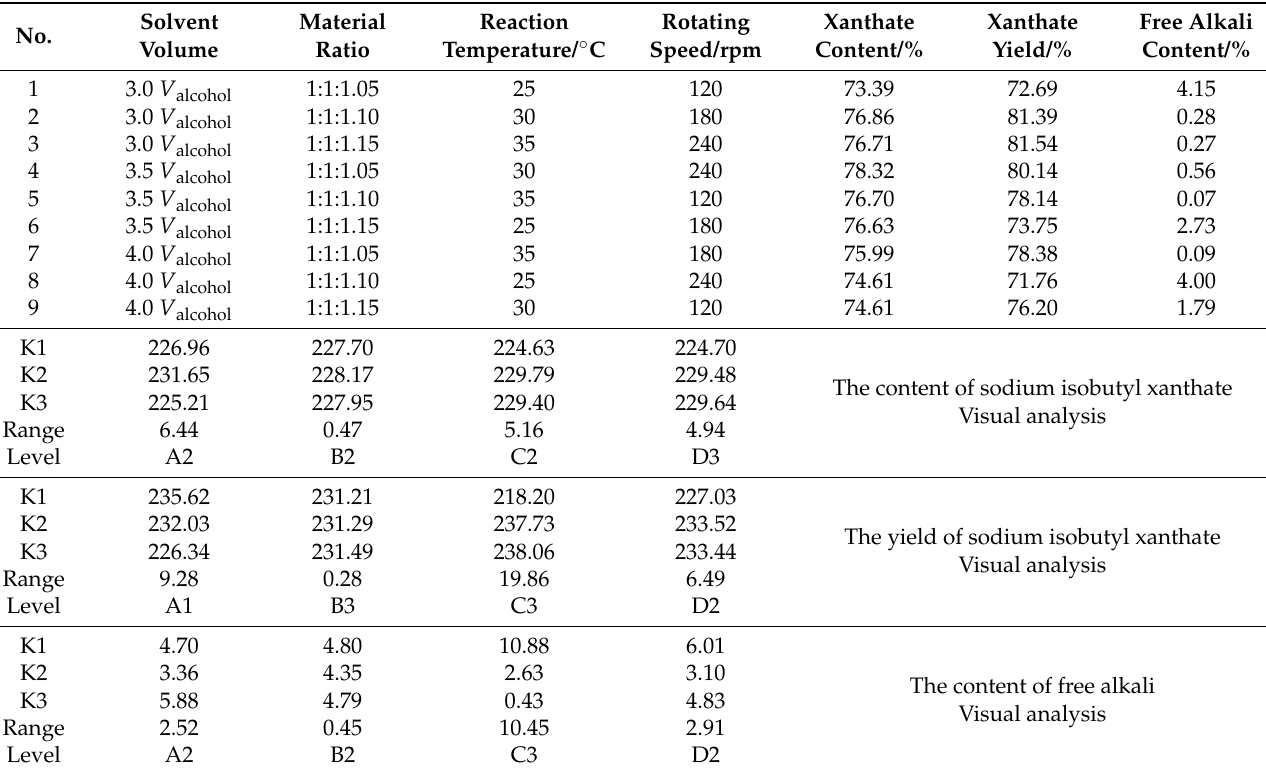
Table 3. Orthogonal experimental